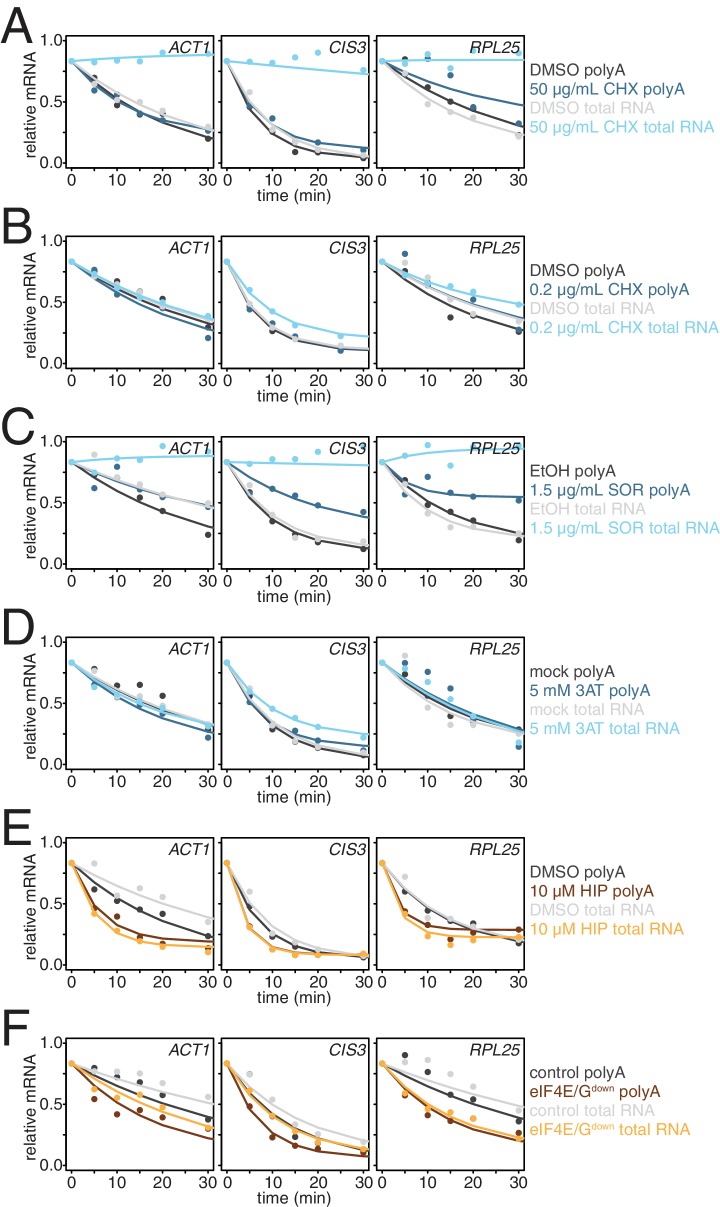
Effects of different modes of translation inhibition on mRNA stability in the absence of mRNA enrichment.(A) Decay profiling of ACT1, CIS3 and RPL25 transcripts was performed for the experiment described in Figure 3—figure supplement 1A in the absence of oligo-dT bead selection (total RNA) and were fitted and plotted against measurements derived in the presence of oligo-dT selection (polyA). (B) Decay profiling as described in (A) was performed for the experiment described in Figure 3B. (C) Decay profiling as described in (A) was performed for the experiment described in Figure 3C. (D) Decay profiling as described in (A) was performed for the experiment described in Figure 3D–G. (E) Decay profiling as described in (A) was performed for the experiment described in Figure 3I. (F) Decay profiling as described in (A) was performed for the experiment described in Figure 3J.